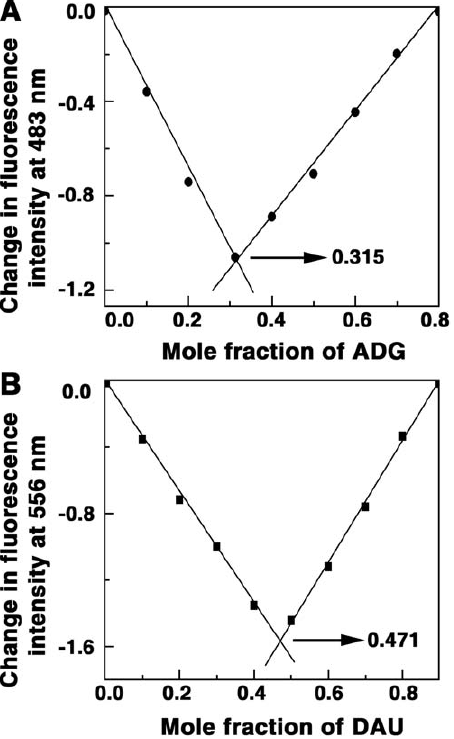
Figure 5. Job’s plot for the binding of ADG and DAU with tRNA. (A) ADG and (B)